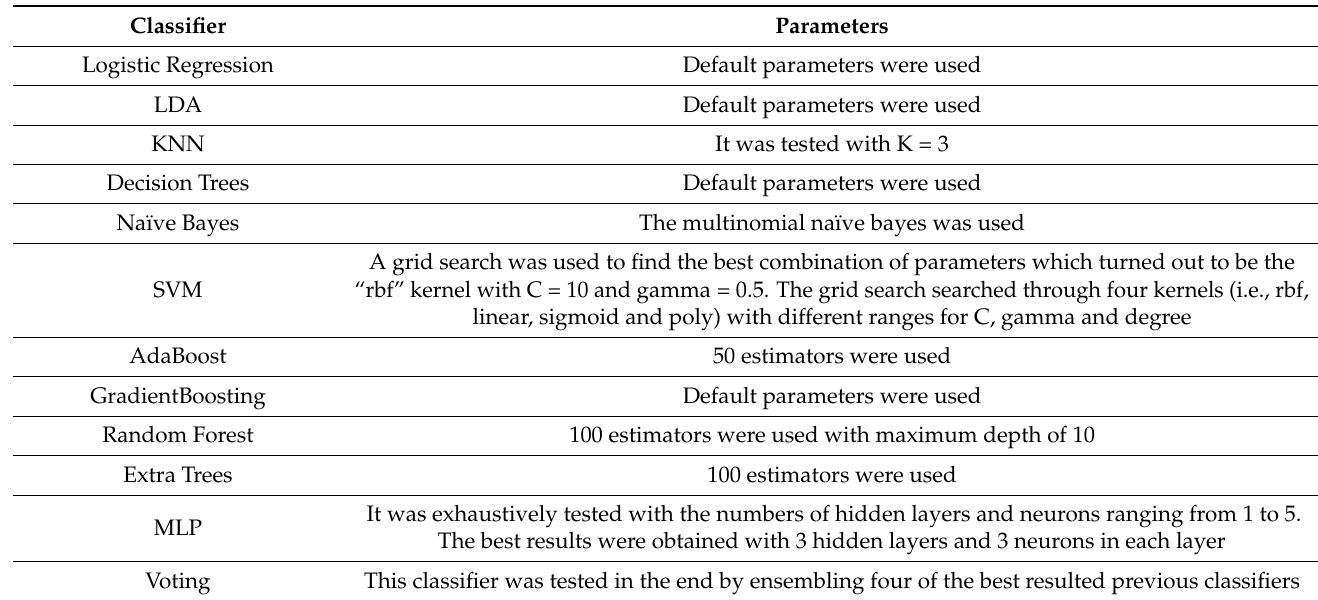
Table 2. Parameters Used for Each